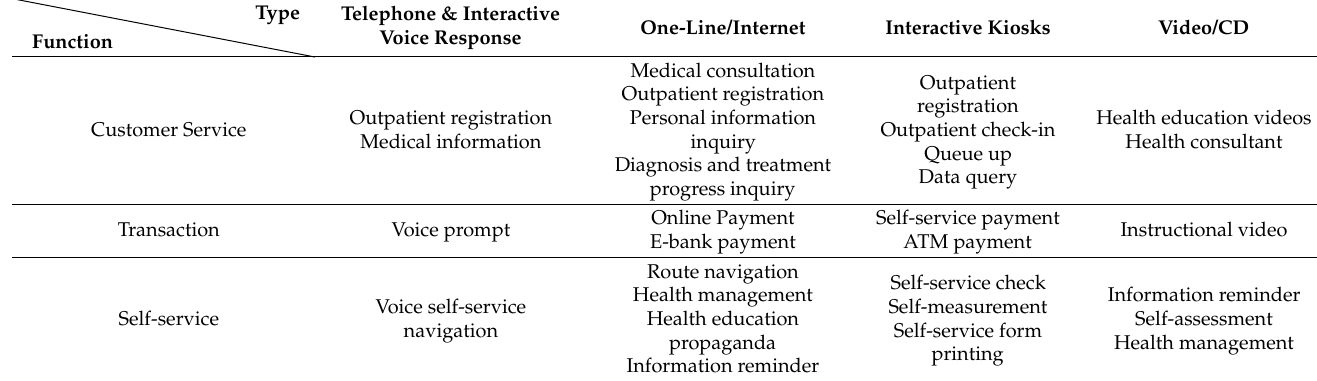
Table 2. Applications of medical self-service technologies